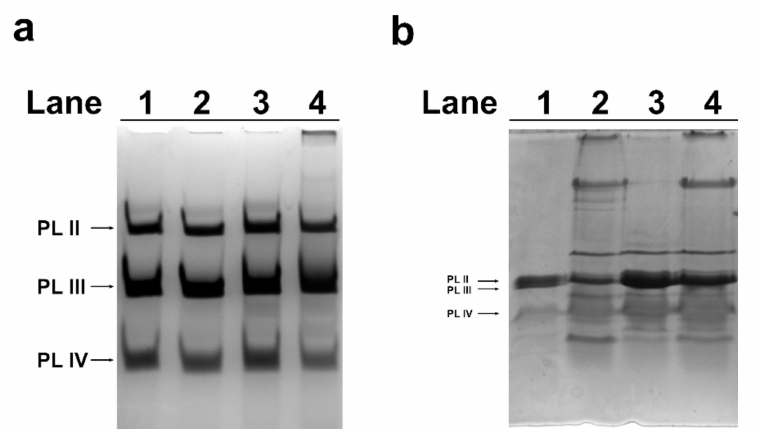
Figure 3. Electrophoretic analyses by acid-urea (AU)-PAGE ( a ) and SDS PAGE ( b ) of M. galloprovin- cialis protamine-like (PL) proteins extracted from unexposed (lane 1) and exposed mussels (lanes 2, 3, and 4): To 1, 10, and 100 pM HgCl 2 , respectively.